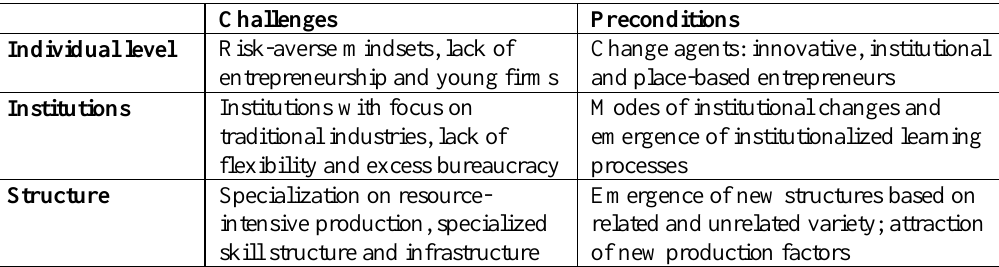
Table 2: Challenges for Regional Transformations and Preconditions for Change Challenges Preconditions Change agents: innovative, institutional Individual level Risk-averse mindsets, lack of entrepreneurship and young firms and place-based entrepreneurs Modes of institutional changes and Institutions Institutions with focus on traditional industries, lack of emergence of institutionalized learning flexibility and excess bureaucracy processes Emergence of new structures based on Structure Specialization on resource- intensive production, specialized related and unrelated variety; skill structure and infrastructure